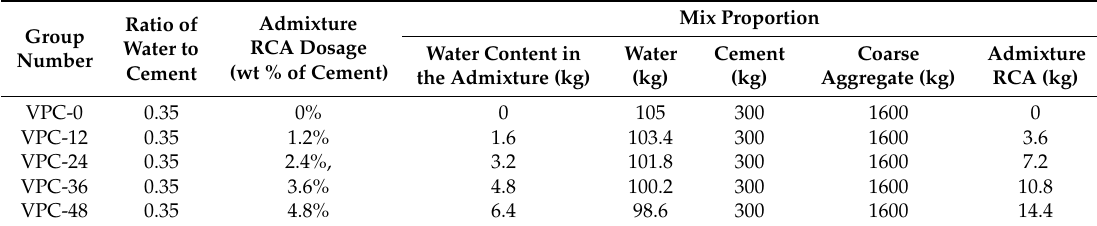
Table 3. Mix proportions of vegetation-pervious concrete (1 m 3